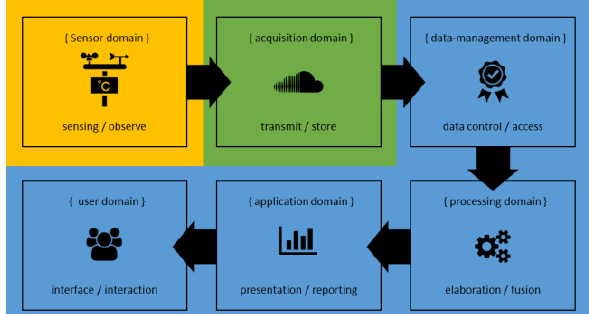
Figure 1. The 4onse monitoring architecture grouped in hardware (yellow), communication (green) and service layer (blue).